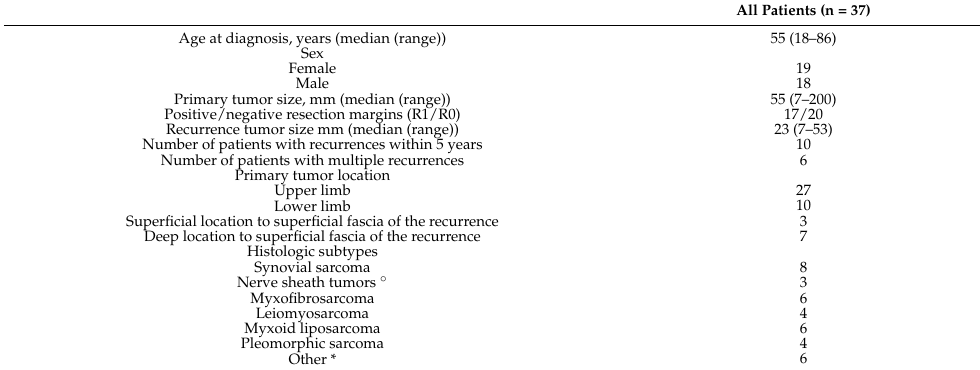
Table 1. Summary of patient’s characteristics.